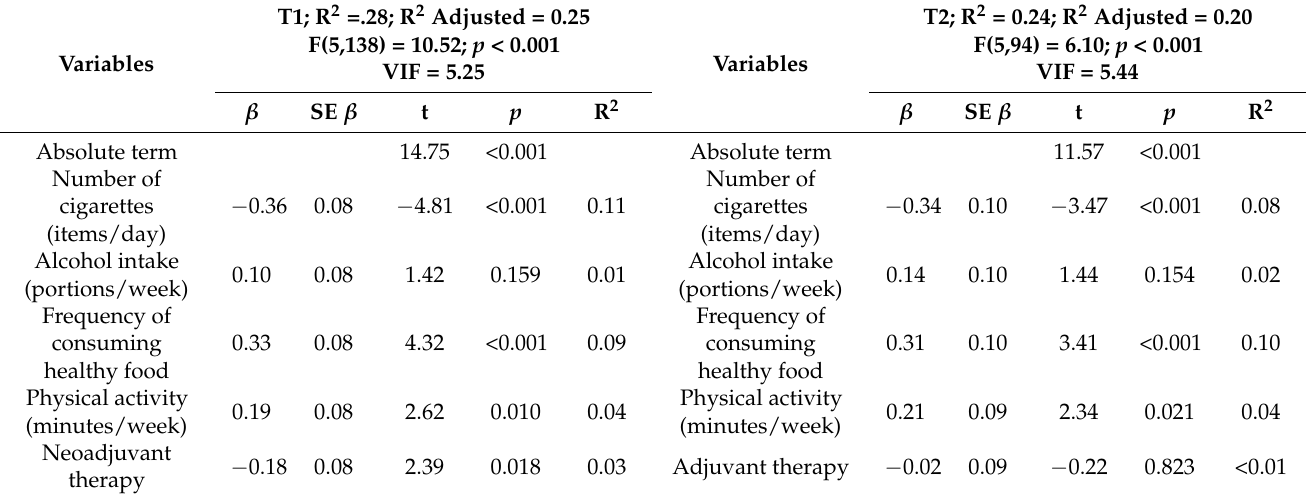
Table 5. The results of the multivariate regression analysis for QoL—social functioning during T1 and T2.